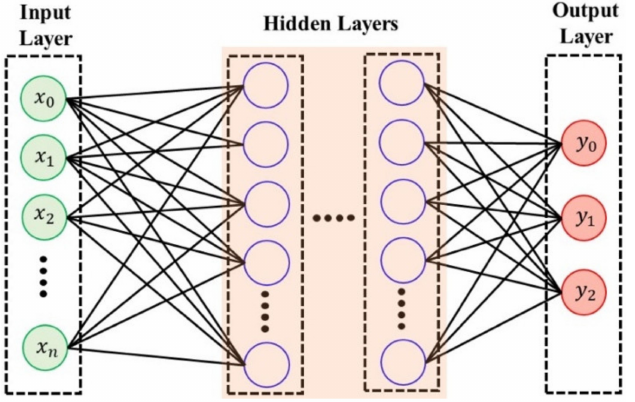
Figure 4. Schematic of a multi-layer